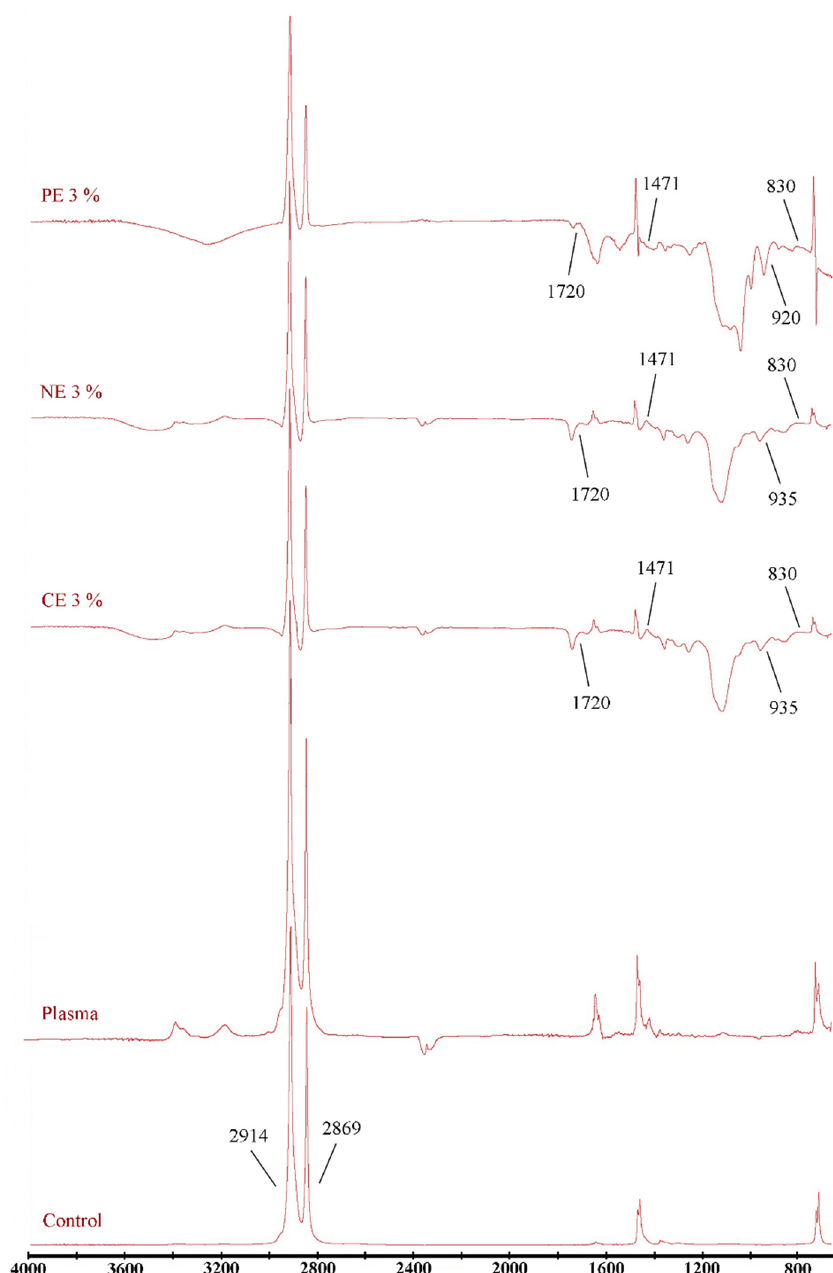
Figure 1. ATR–FTIR of LDPE film treated with cold plasma containing CE-, NE-, and PE-stabilized MFEO.